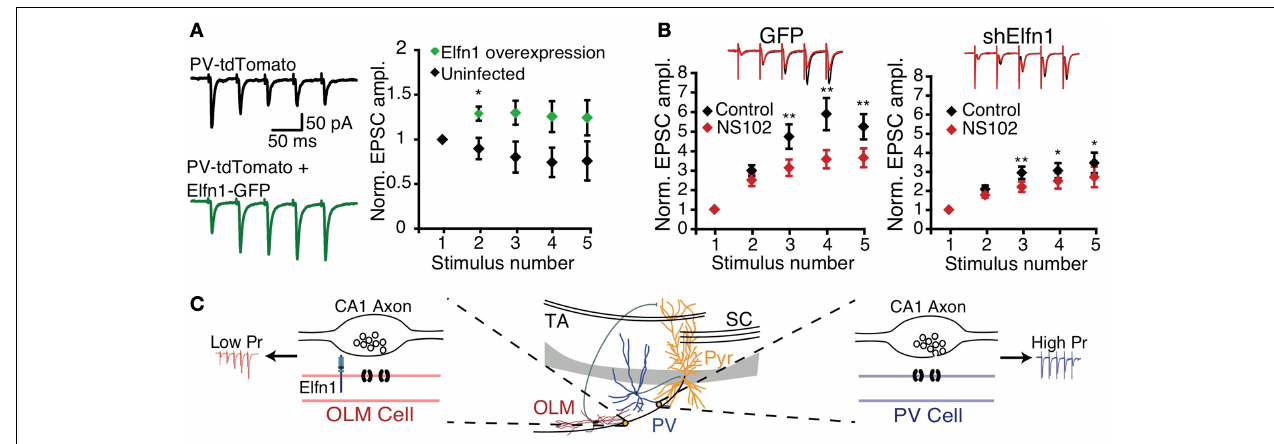
FIGURE 2 | Postsynaptic Elfn1 controls presynaptic transmitter release. (A) Five stimuli at 20Hz in the alveus produce short-term depression in stratum pyramidale or oriens PV INs (black). PV neurons overexpressing Elfn1-GFP no longer short-term depress (green). Left: example traces, right: ensemble normalized EPSC amplitude. (B) SOM INs normally facilitate (black), but facilitation is attenuated by GluR6-selective kainate receptor antagonist NS102 (left, red, n = 8). ShElfn1 expression reduces NS102 effect (right, n = 14). Top: example